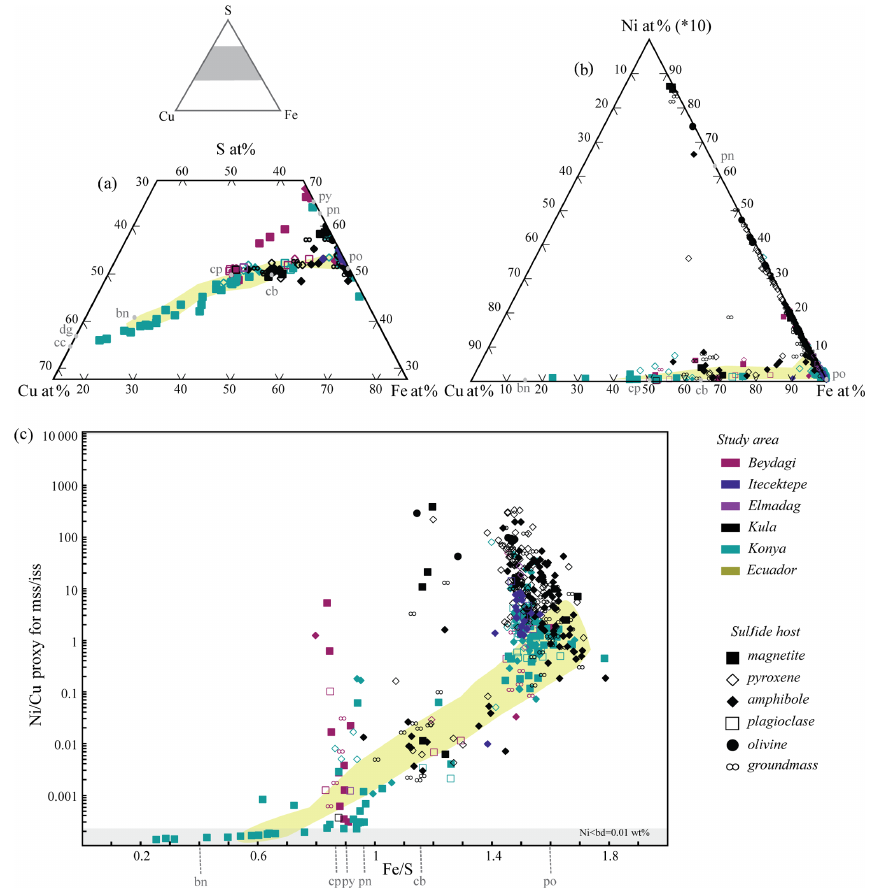
Figure 7. Sulfide composition in the Cu–Fe–S system and Ni–Fe–Cu from individual mineral analyses by EPMA. The colour shows the study area, and the shape indicates the host mineral in which magmatic sulfides were found. Note the progressive Ni / Cu depletion as we switch from more mafic suites (e.g. Kula) and early crystallising host minerals (olivine, pyroxene, and amphibole) to more evolved (e.g. Konya) and later crystallising mineral phases (magnetite). The grey fields correspond to analyses that resulted in Ni or Cu below the determination limit equal to 0.01wt% that for discussion purposes are shown here. For the dataset, see Table 4 at